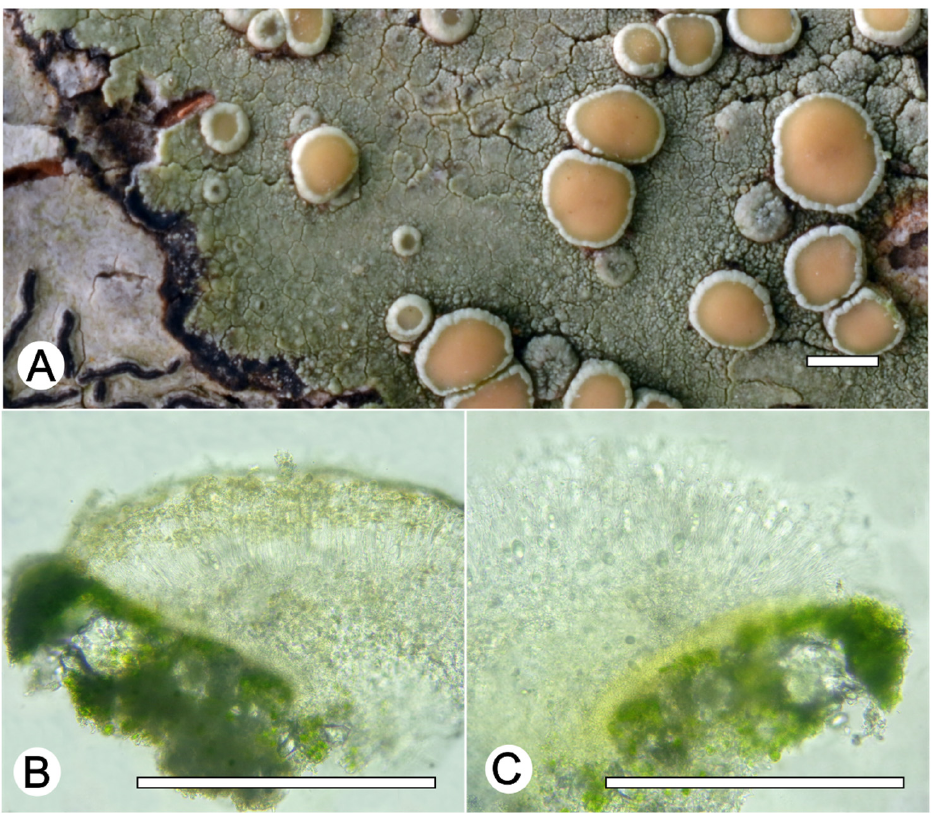
Figure 6. Lecanora neohelva sp. nov. ( A ) Thallus with ascomata (holotype ISE-52342); ( B ) Apothecial section in water (holotype ISE-52342); ( C ) Apothecial section after KOH treatment (holotype ISE- 52342). Scale bars: ( A ), 1 mm; ( B , C ), 100 µm. M MycoBank MB